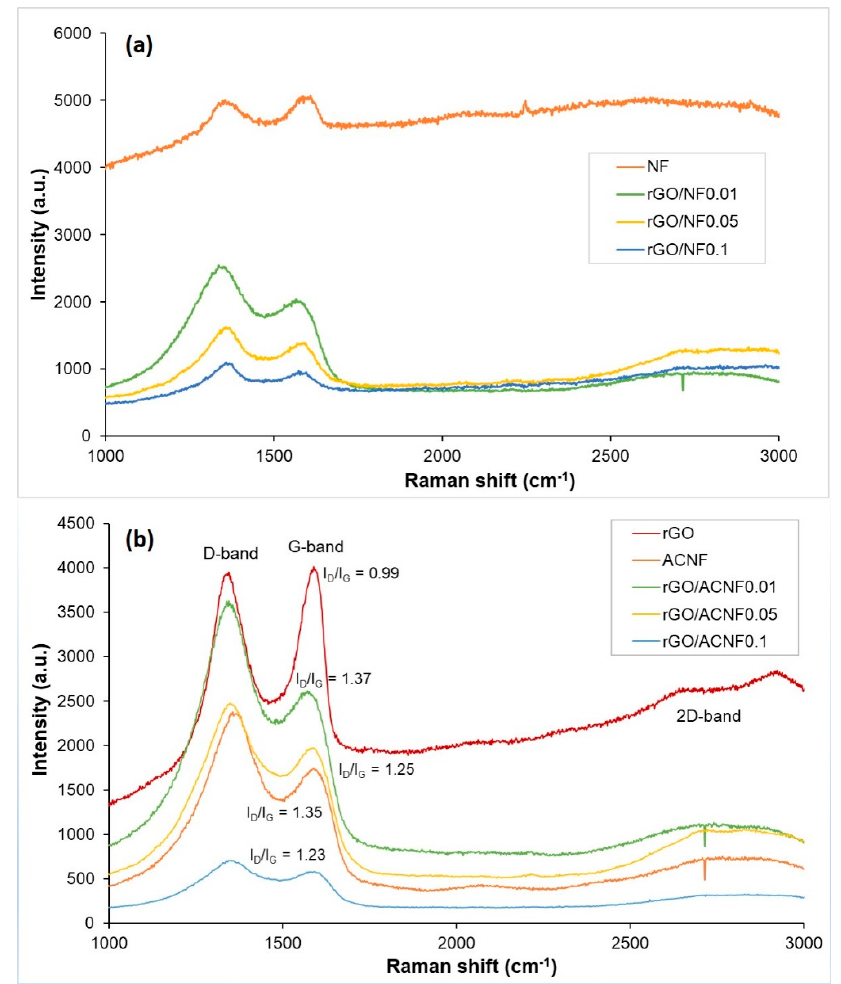
Figure 3. Raman spectra of rGO, ACNF and rGO/ACNF. ( a ) materials before activation and ( b ) materials after activation.